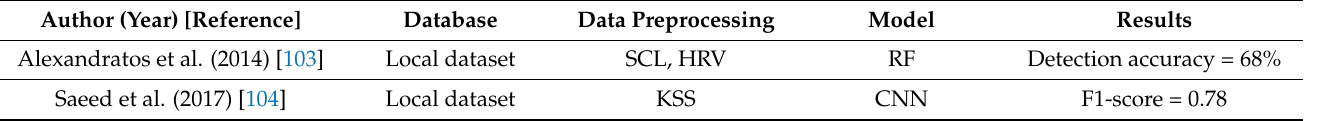
Table 9. Commercial application of microarousal